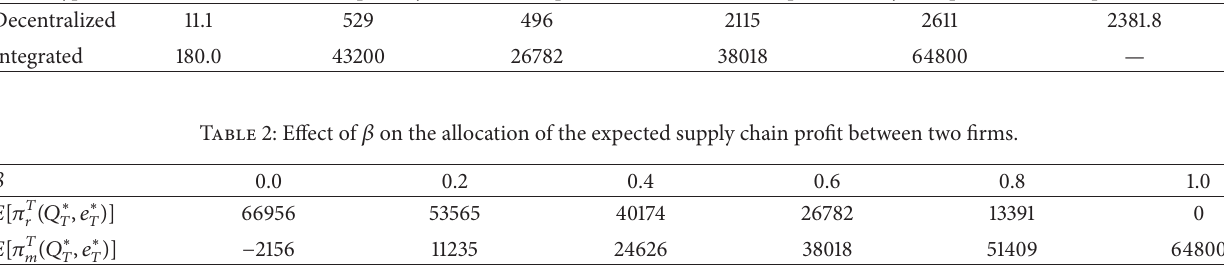
Table 1: Optimal results of the integrated and decentralized systems.